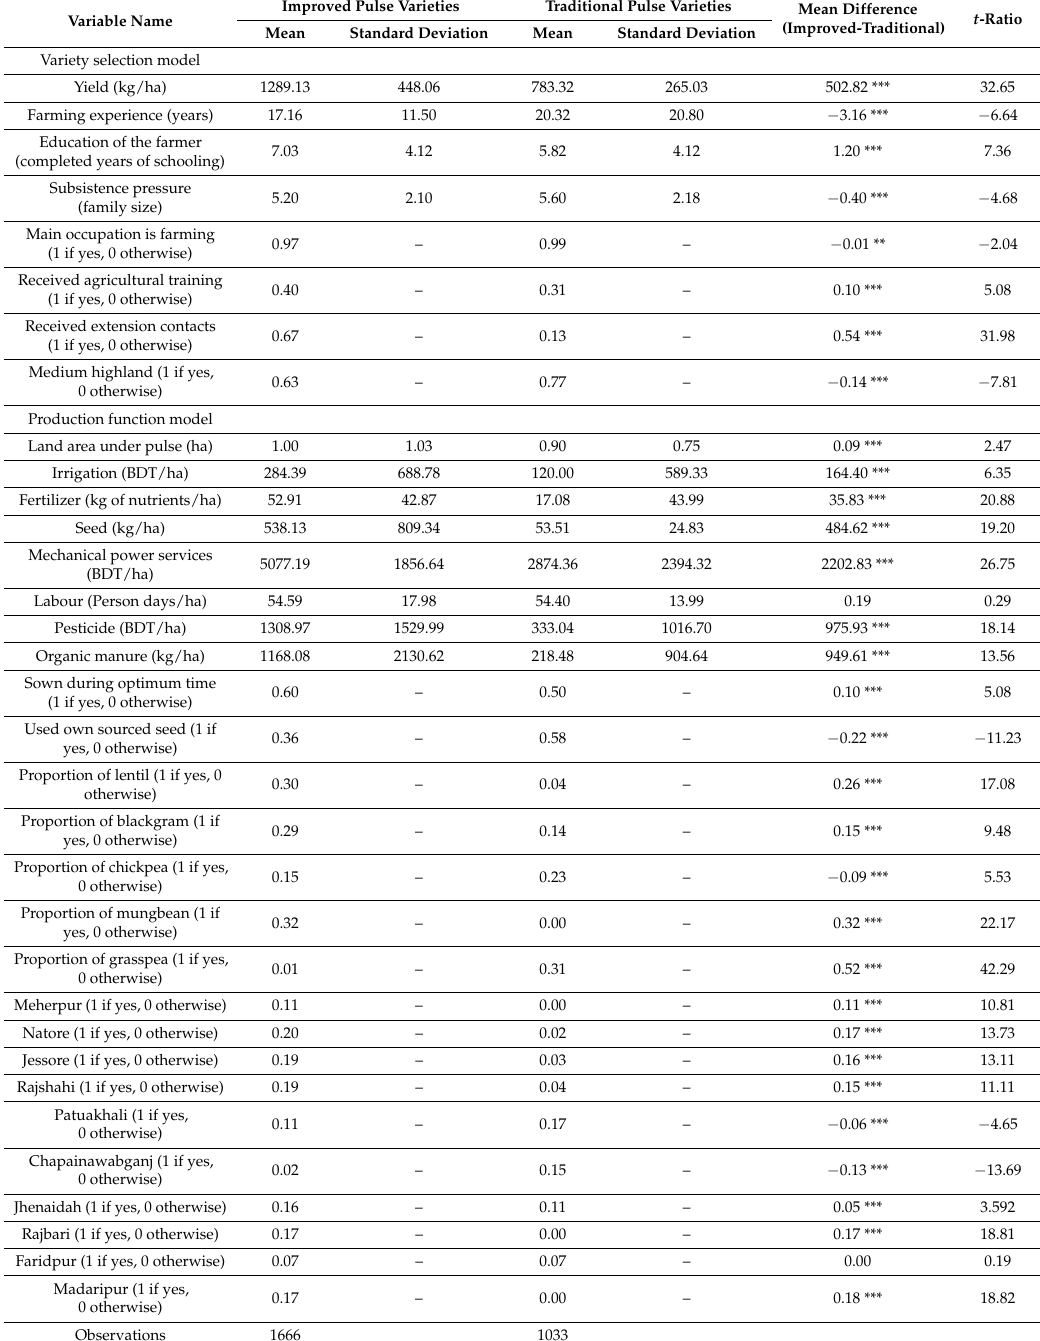
Table 4. Comparison of key indicators by pulse